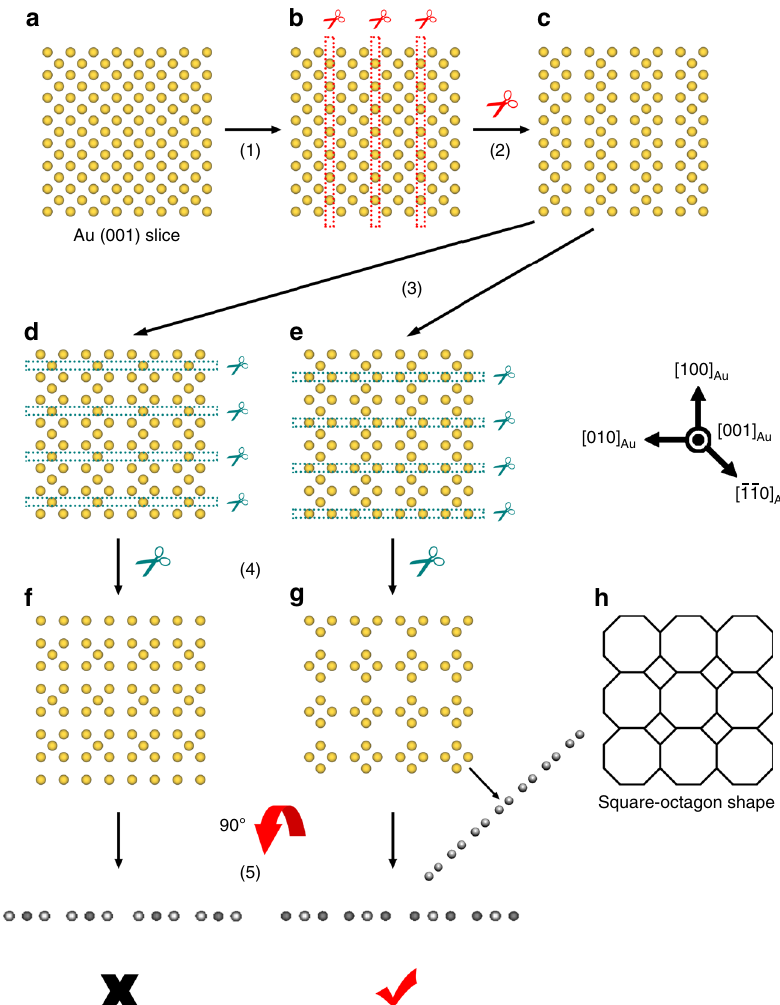
Fig. 5 Structural determination of Au atom position in the reconstructed Au (001) surface on the basis of the HAADF-STEM images. a A monolayer Au (001) slice viewed from Au [001] direction. b Deleting the atoms in one column every three columns to make the gaps meet the periodicity viewed from Au [100] direction. c The structure with remaining Au atoms after process in ( b ). d , e Two different ways to delete the atoms in one row every three rows to make the gaps meet the periodicity viewed from Au [100] direction. f The structure with remaining Au atoms after process in ( d ), which is not consistent with the experimental HAADF-STEM images. g The structure with remaining Au atoms after process in ( e ), which is consistent with the experimental HAADF-STEM images in every directions we have observed. h The square-octagon structure composed by the remaining monolayer Au